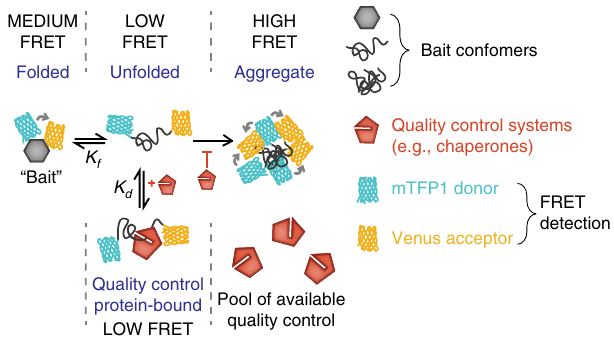
Fig. 1 Design strategy for probing proteostasis ef fi ciency. Scheme of how the bait biosensor module measures collective cellular chaperone engagement by binding to unfolded barnase and in preventing aggregation. Medium FRET and low FRET: binding of quality control machinery to barnase bait pulls the equilibrium away from folded barnase, reducing the FRET signal in the soluble pool. High FRET: quality control systems reduce aggregate accumulation, thereby reducing the number of cells with high-